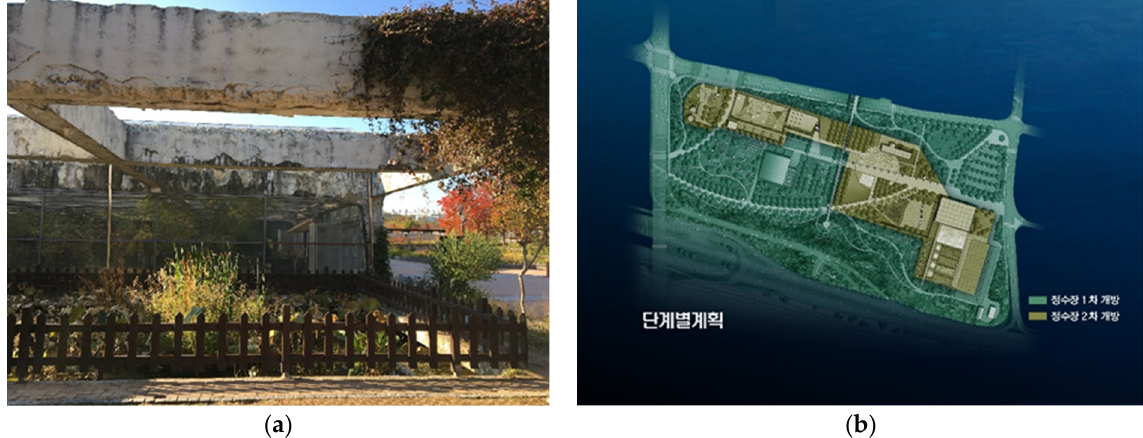
Figure 6. Seoul Forest Park: ( a ) butterfly garden; ( b ) phasing plan for the original design. Sources: ( a ) author’s photograph; ( b ) Dongsimwon Landscape Design and Construction Co. et al., [48].